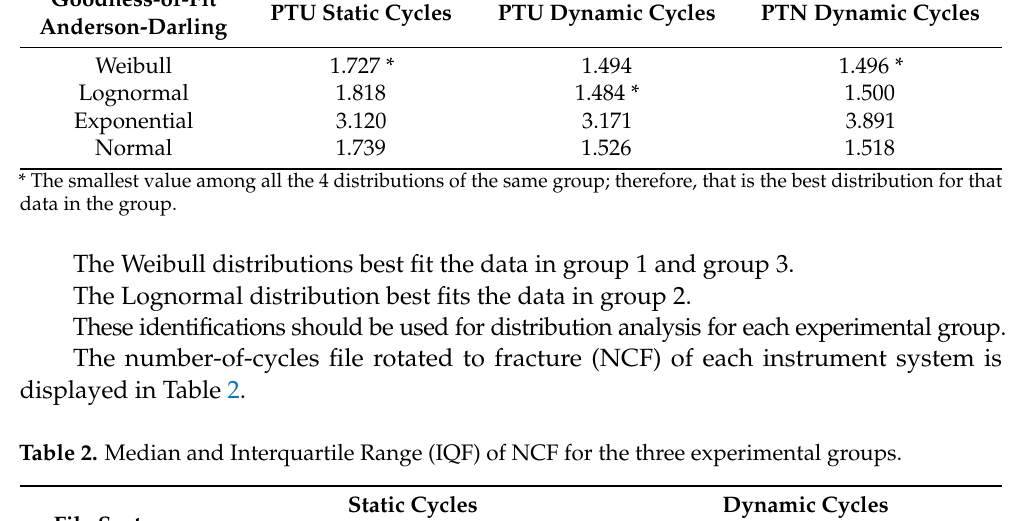
Table 1. The Goodness-of-Fit of the three experimental groups. Goodness-of-Fit